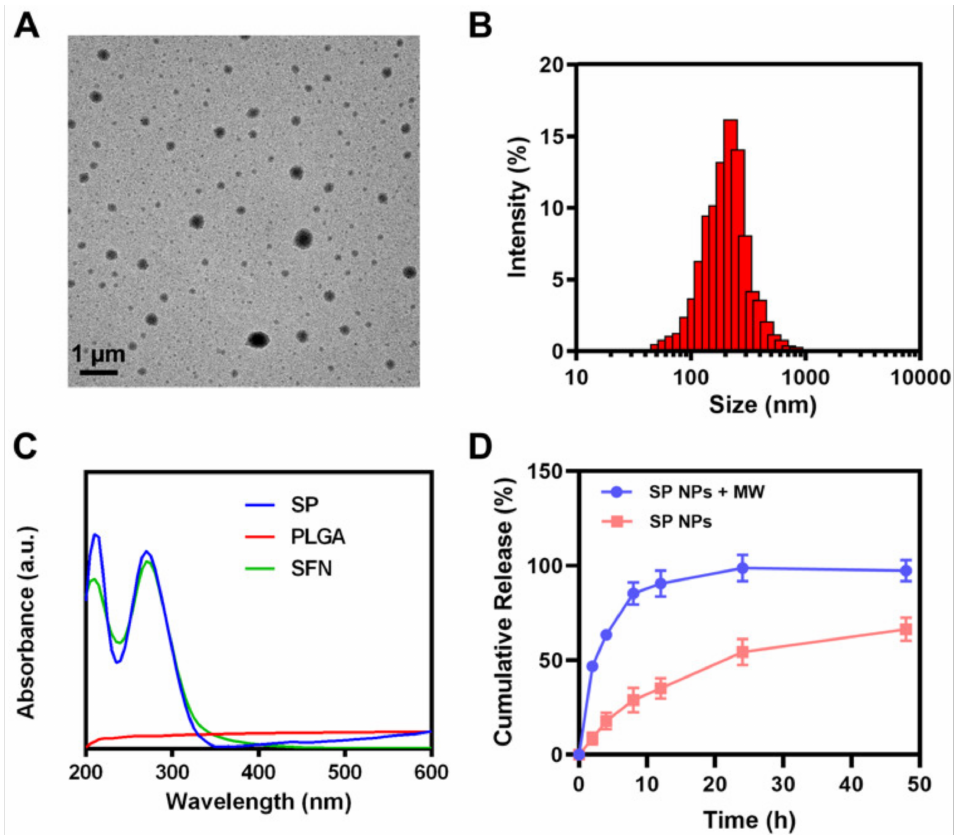
Figure 1. ( A ) TEM image of SP NPs. ( B ) Size distribution of SP NPs (containing 0.01 mg/mL SFN). ( C ) UV − vis spectrum of SP, PLGA, and SFN. ( D ) Cumulative SFN release from SP with or without MW (0.9